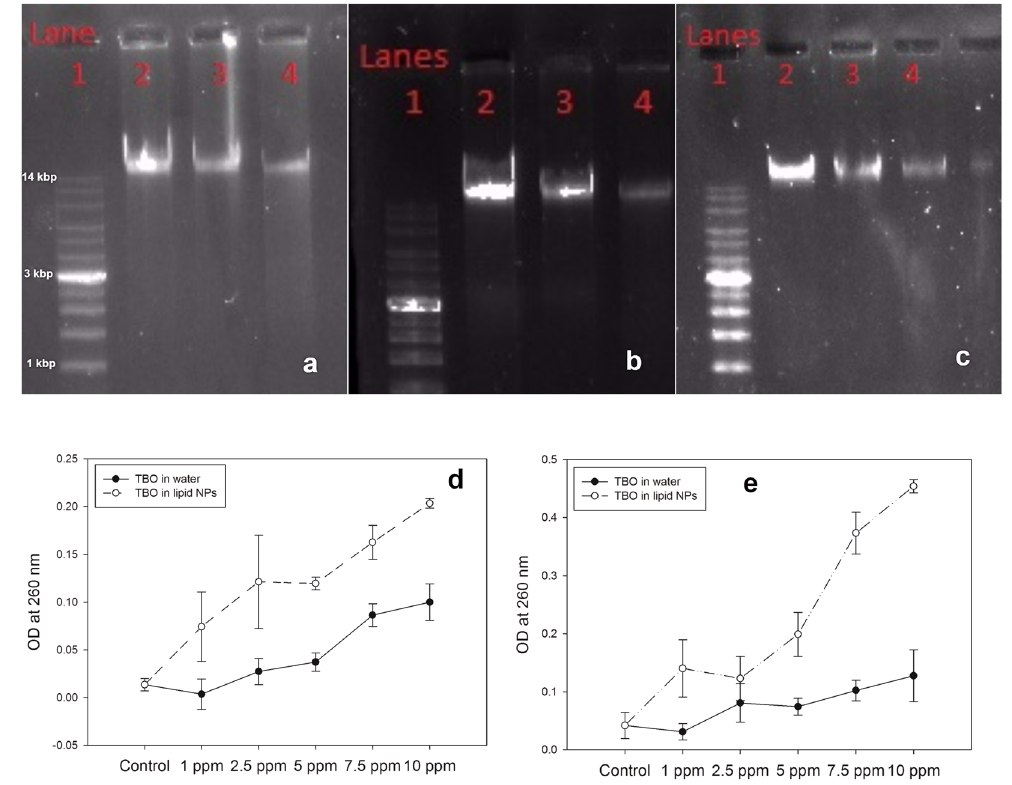
Figure 3. DNA damage assay by gel electrophoresis of ( a ) E . coli , ( b ) P . aeruginosa and ( c ) S . aureus after treatment with PAT using TBO in water and TBO in lipid nanoparticles. In all the images, lane 1 was loaded with DNA ladder. Lane 2 was loaded with DNA extracted from bacteria treated with sterile saline. Lanes 3 and 4 were loaded with DNA extracted from bacteria treated with PAT using TBO in water and TBO in lipid nanoparticles. Analysis of bacterial DNA exudation from ( d ) E . coli and ( e ) S . aureus after treatment with PAT using TBO in water and TBO in lipid nanoparticles revealed that DNA exudation was increased after usage of TBO in lipid